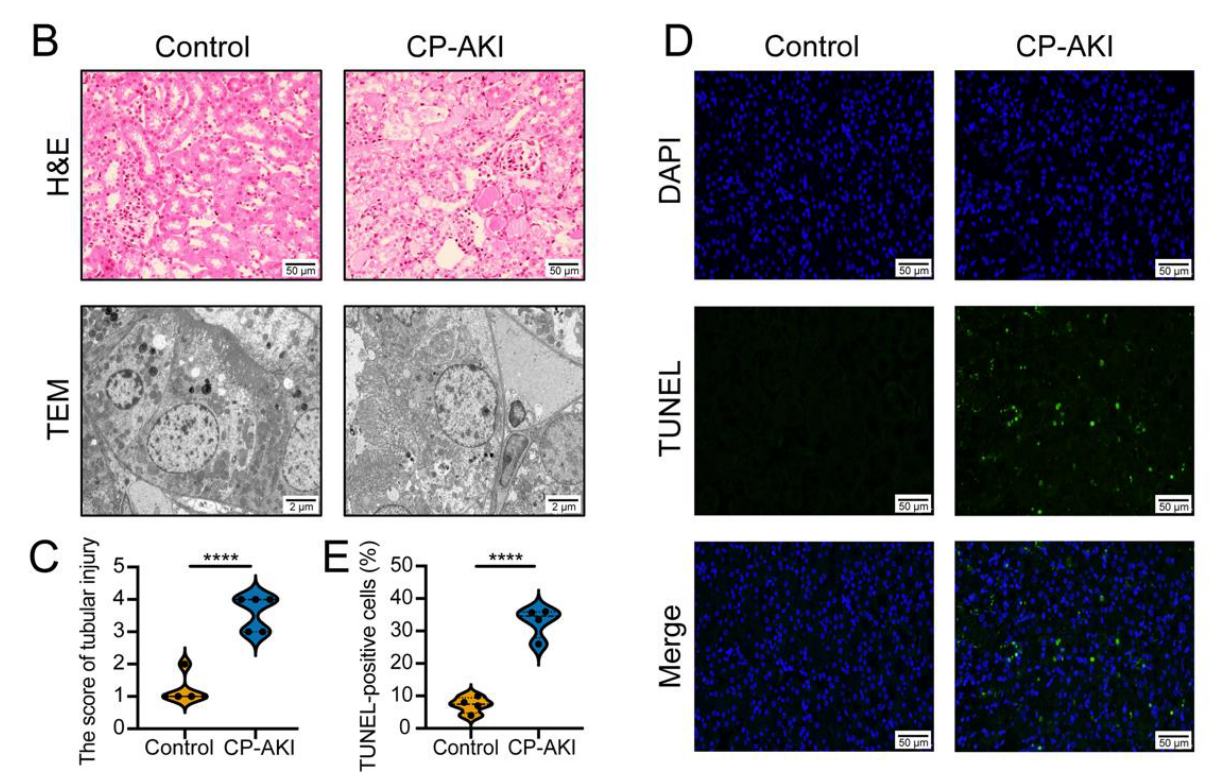
Figure 1. Cisplatin-induced acute kidney injury (CP-AKI) mouse model. ( A ) Experimental design workflow. ( B ) Representative photomicrographs of tubular cell injuries in mouse kidney tissues (hematoxylin and eosin (H&E) staining; original magnification, 200 × ) and representative photomi- crographs of mitochondrial ultrastructural changes in renal tubular epithelial cells (original mag- nification, 5000 × ). ( C ) Quantitative analysis of histologic scoring ( n = 5 in each group). ( D ) Im- munofluorescent labeling for terminal deoxynucleotidyl transferase dUTP nick-end labeling (TUNEL) in mouse kidney tissue sections of the two groups (original magnification, 200 × ). Apoptotic cells in mouse kidney tissues were evaluated using TUNEL staining (green). Nuclei were stained with 4 (cid:48) ,6-diamidino-2-phenylindole (DAPI) (blue). ( E ) Quantitative analysis of TUNEL-positive cells ( n = 4 in each group). Over 200 cells in each group were evaluated to determine the percentage of TUNEL-positive cells. **** p <